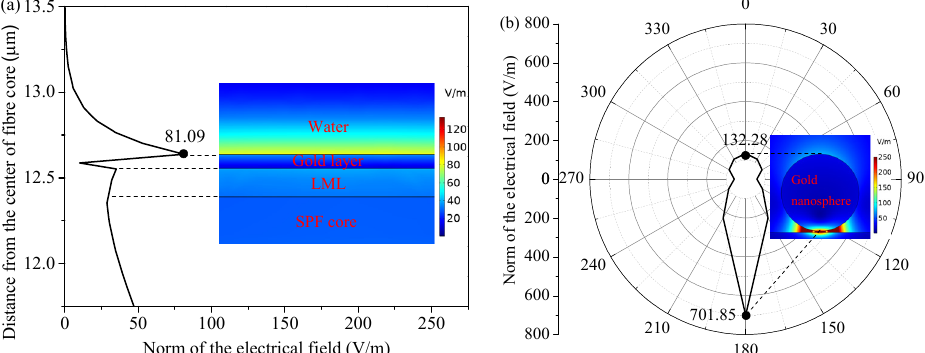
Figure 2. ( a ) Axial electric field distribution of the LR − SPR sensor and ( b ) electric field distribution of the gold nanosphere wall at different angles in the gold nanosphere − modified LR − SPR sensor. Inset: mode field distribution of the LR − SPR sensor and the gold nanosphere − modified LR − SPR sensor.